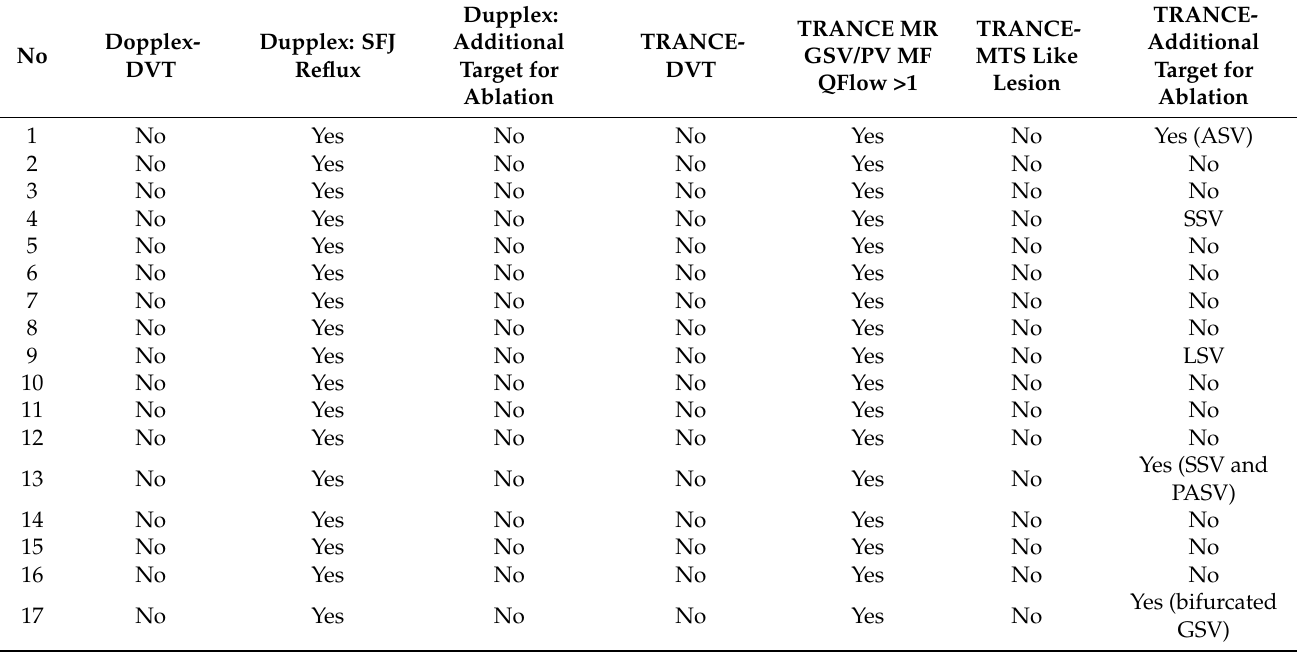
Table 3. Diagnostic tool performance for venous disease in these 30